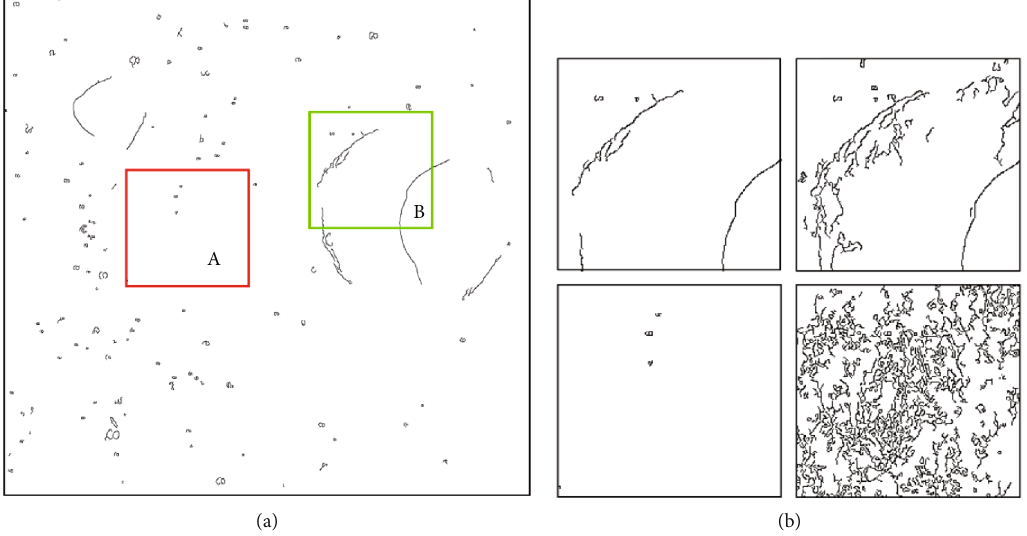
Figure 3: Performance and results of the adaptive dual-threshold selection method.